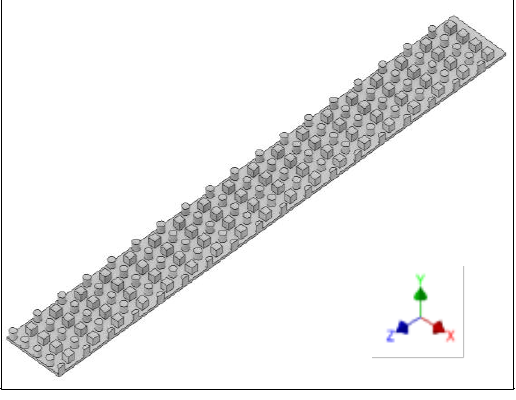
Figure 1. Section cut of the heat sink